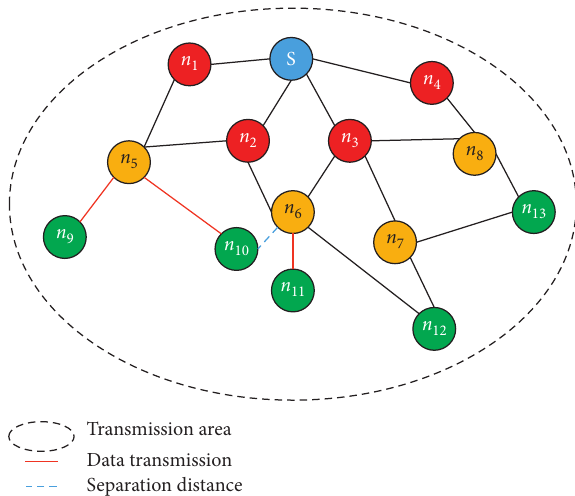
Figure 10: Broadcast link scheduling based on EDTC.